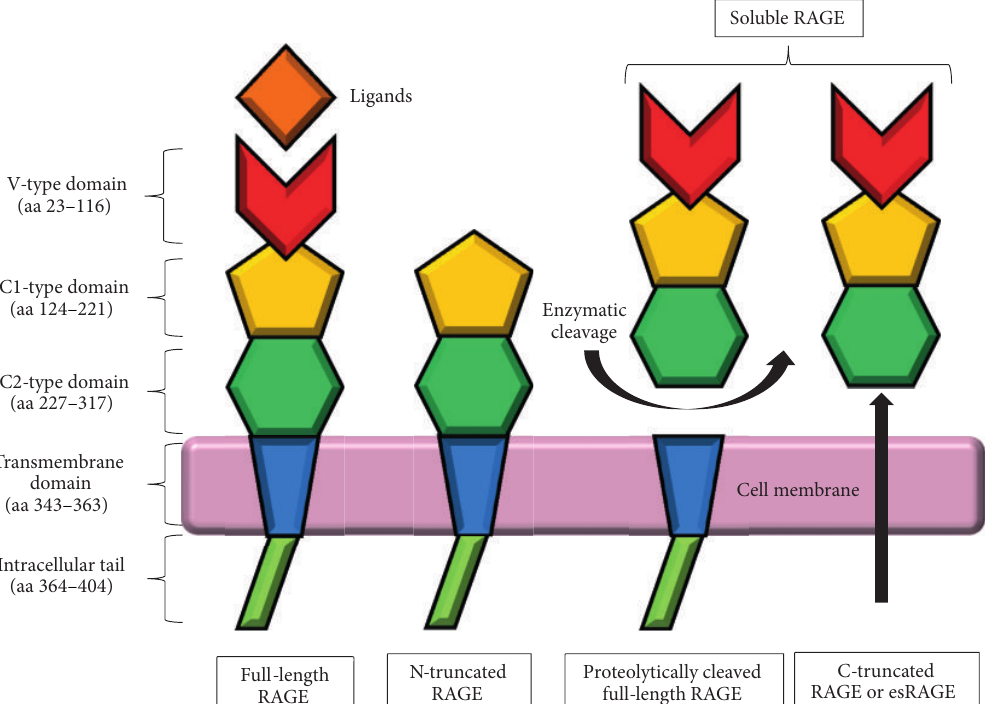
Figure 1: Schematic representation of full-length RAGE and its splice variants. RAGE is composed of an intracellular tail, a transmembrane domain, and an extracellular domain consisting of three immunoglobulin-like domains, one V-type followed by two C-type (C1 and C2) domains. The V-type domain is essential for ligand binding, and deletion of this domain results in an N-truncated form. The C-truncated, circulating soluble RAGE corresponds to the extracellular domain of RAGE lacking the intracellular tail and transmembrane domains. It may derive via proteolytic cleavage of full-length RAGE from the cell surface (cRAGE) or via alternative splicing of RAGE mRNA (esRAGE). C: constant; V: